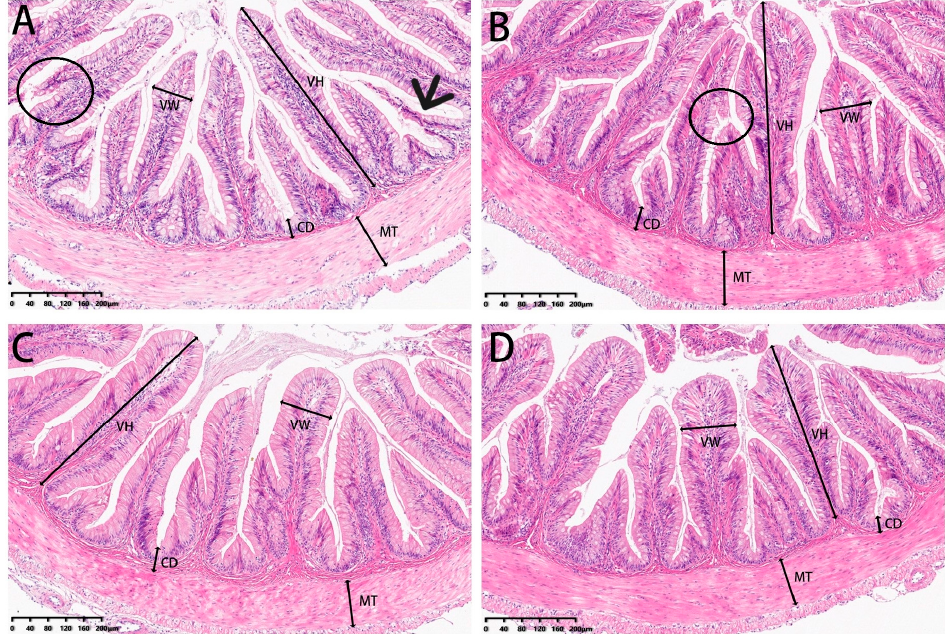
Figure 13. HE staining of the intestine sections of juvenile largemouth bass fed with diets containing 0% ( A ), 2% ( B ), 4% ( C ) and 8% ( D ) SBL (magnification × 100). VH: villus height, VW: villus width, MT: muscular thickness, CD: crypt depth. Circles represent intestinal villi fall o ff . Black arrow represents villous atrophy.